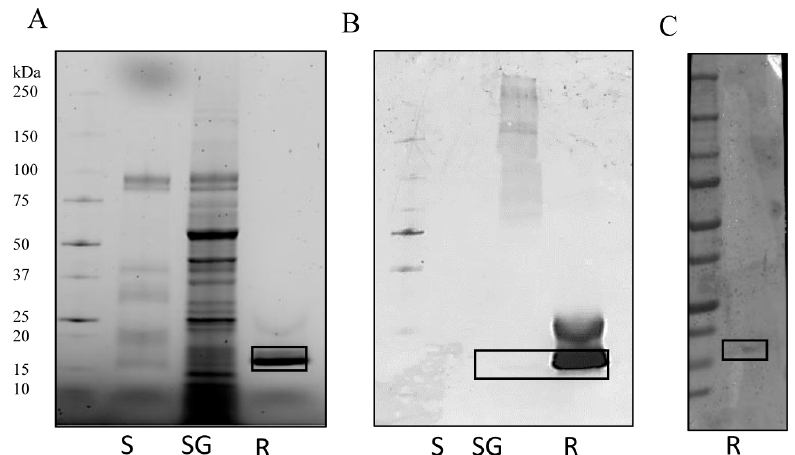
Figure 4. Detection of endogenous IrSPI protein expression. Tick saliva (S) and salivary gland extracts (SG) were obtained from a pool of 17 I. ricinus females from the field after a five-day pre-feeding step on rabbits. To each lane, samples of 10 µ L of saliva (S), 10 µ L of salivary gland extract (SG), and 1.4 µ g of recombinant IrSPI (R) were loaded. ( A ) SDS-PAGE electrophoresis and UV visualization. ( B ) Western blot analysis using antiserum from an IrSPI-immunized mouse. ( C ) Western blot analysis using an antiserum from a tick-infested rabbit. Bands corresponding to IrSPI are framed with boxes.